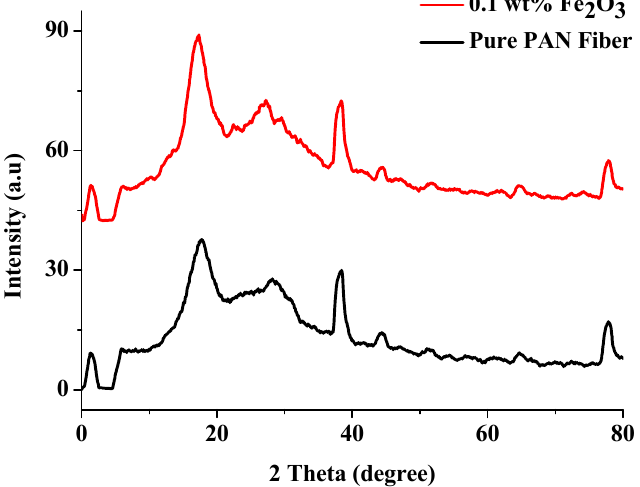
Fig. 6. XRD patterns of pure PAN fibers and PAN/Fe 2 O 3 nanocomposite fibers with 1 wt% Fe 2 O 3